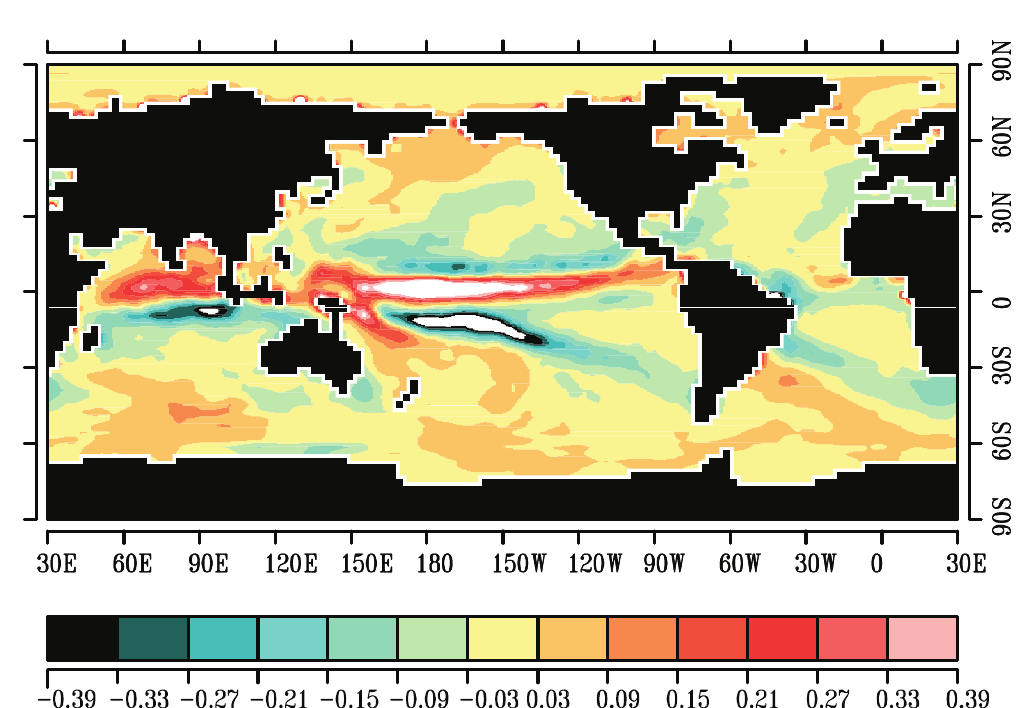
Fig. 2. Centennial linear trend in the freshwater flux (P–E+R, precipitation minus evaporation plus river run- off ) [mm/(d*decade)] obtained from the transient greenhouse warming simulation and computed over the period 2000-2100. Note the freshening in the equatorial Pacific associated with the increased El Niño frequency and the strongly reduced freshwater influx over the tropical